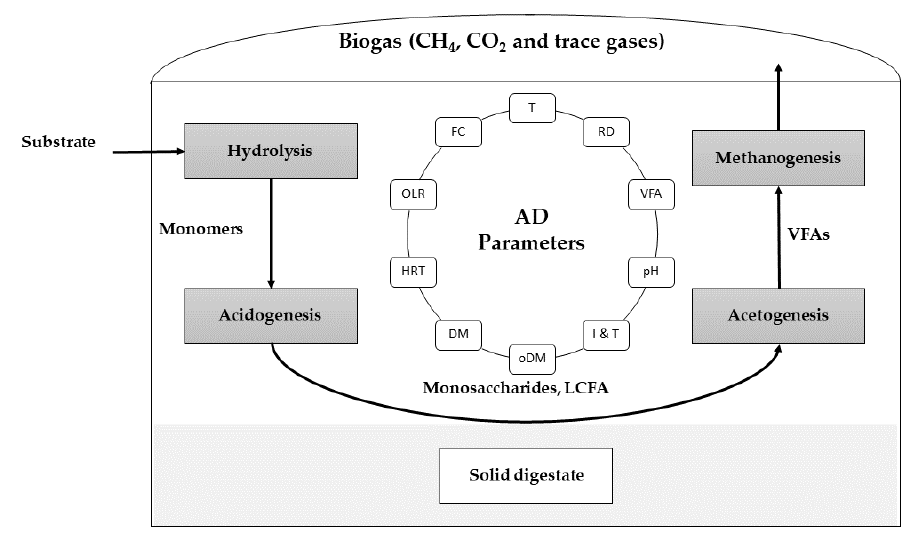
Figure 2. Operational parameters of the AD process (LCFA: long chain fatty acids) [9,70,71].